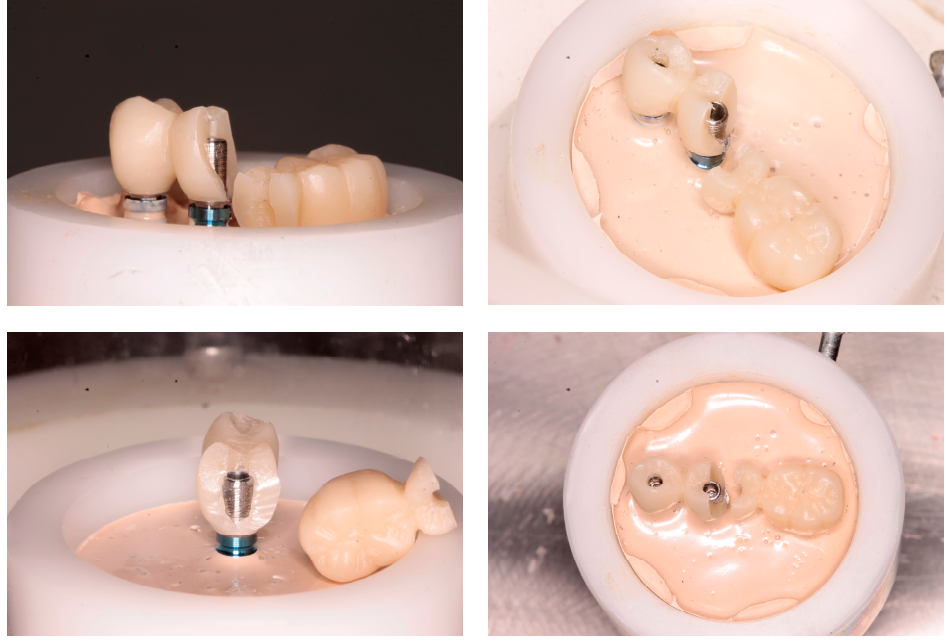
Figure 7. Fracture at the distal abutment level.